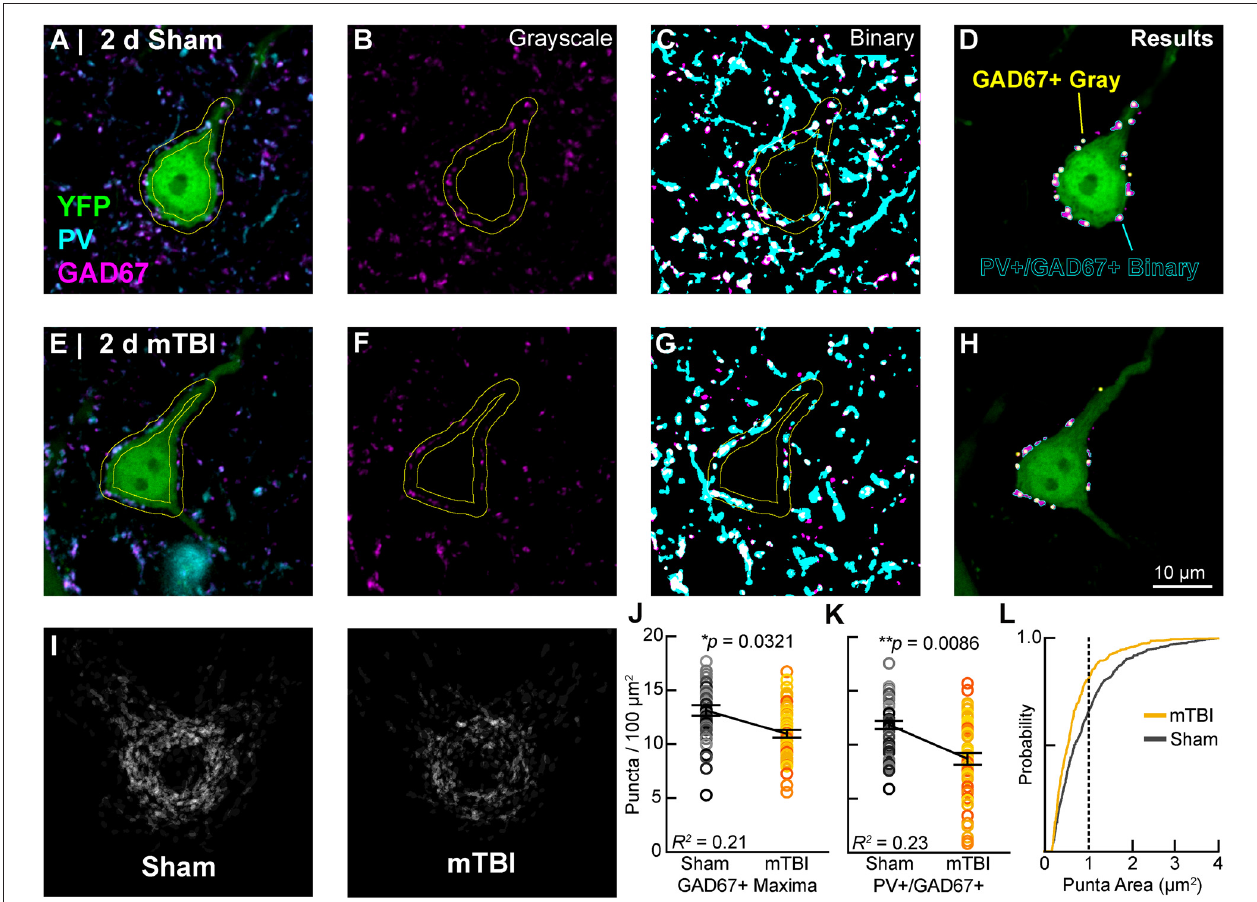
FIGURE 9 | Intact YFP+ pyramidal neuron perisomatic GABAergic bouton density decreases 2 days post-mTBI. Representative images of sham (A–D) and mTBI (E–H) glutamate decarboxylase-67 (GAD67+; B,F ; magenta) and parvalbumin (PV+; A,C,E,G ; cyan) punch along the perimeter of YFP+ pyramidal neurons ( A,E,D,H ; green). Perisomatic bouton density was quantified in 8-bit gray scale images of GAD67 expression (B,F,J) and also binary images of colocalized PV+/GAD67+ puncta (C,G,I,K,L) . (D,H) Outcome of automated quantification using gray scale and binary images was comparable. Perisomatic GAD67 expression (magenta) and result of gray scale analysis (yellow dots) largely overlapped with results of PV+/GAD67+ binary image analysis (cyan outlines). (I) A qualitative decrease in perisomatic GABAergic bouton density is seen in superimposed images of binary PV+/GAD67+ profiles. (J,K) Multilevel analysis with animals as a random variable depicted by different shades for sham (gray) and mTBI (gold/orange). Data summarized with means and SEM error bars. GAD67+ maxima in gray-scale images and PV+/GAD67 puncta in binary images were both significantly reduced in mTBI vs. sham. The absolute values as well as relative decrease were similar between gray-scale and binary image analyses. (L) Cumulative frequency distribution of PV+/GAD67+ puncta area. Vertical line at 1 µ m 2 corresponds to average size of a GABAergic presynaptic bouton. This shift in the mTBI plot shows that PV+/GAD67+ puncta approximating the average area of a GABAergic bouton accounting for the majority of the